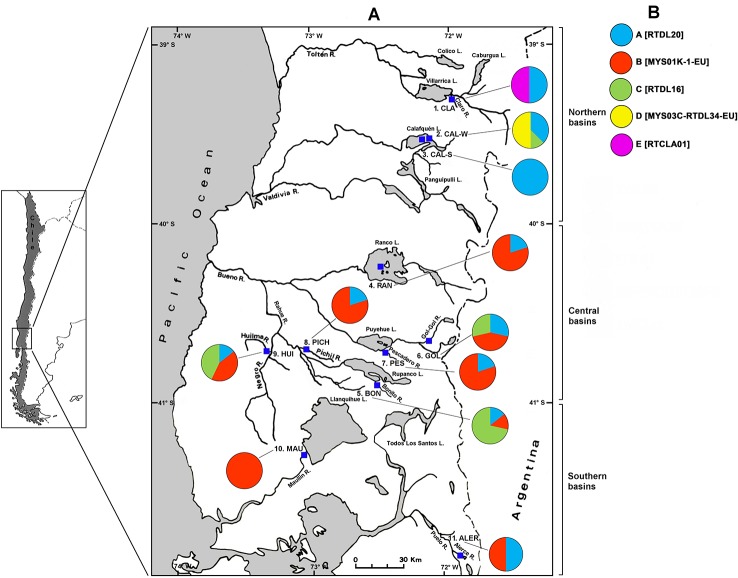
Map of collection sites and haplotype frequency of naturalized populations of rainbow trout from southern Chile. (A) Collection sites (blue squares) were as follows: 1) CLA (Claro River), 2) CAL-W (Calafquén Lake-winter spawn), 3) CAL-S (Calafquén Lake-spring spawn), 4) RAN (Ranco Lake), 5) BON (Bonito River), 6) GOL (Gol-Gol River), 7) PES (Pescadero River), 8) PICH (Pichil River), 9) HUI (Huilma River), 10) MAU (Maullín River), and 11) ALER (Alerce River). Populations were classified as belonging to different geographic groups (indicated in brackets at the righ side of the figure) as follows: northern basins group: 1 + 2+3 populations, central basins group: 4 + 5+6+7+8+9 populations and southern basins group: 10 + 11 populations. (B) Haplotype assignments scheme for the mtDNA control region based on reference haplotypes. Haplotype assignments are presented with specific colours within coloured pie charts that represent their relative frequency within each population. Haplotype labels correspond to those indicated in
Supplementary Table 1
.